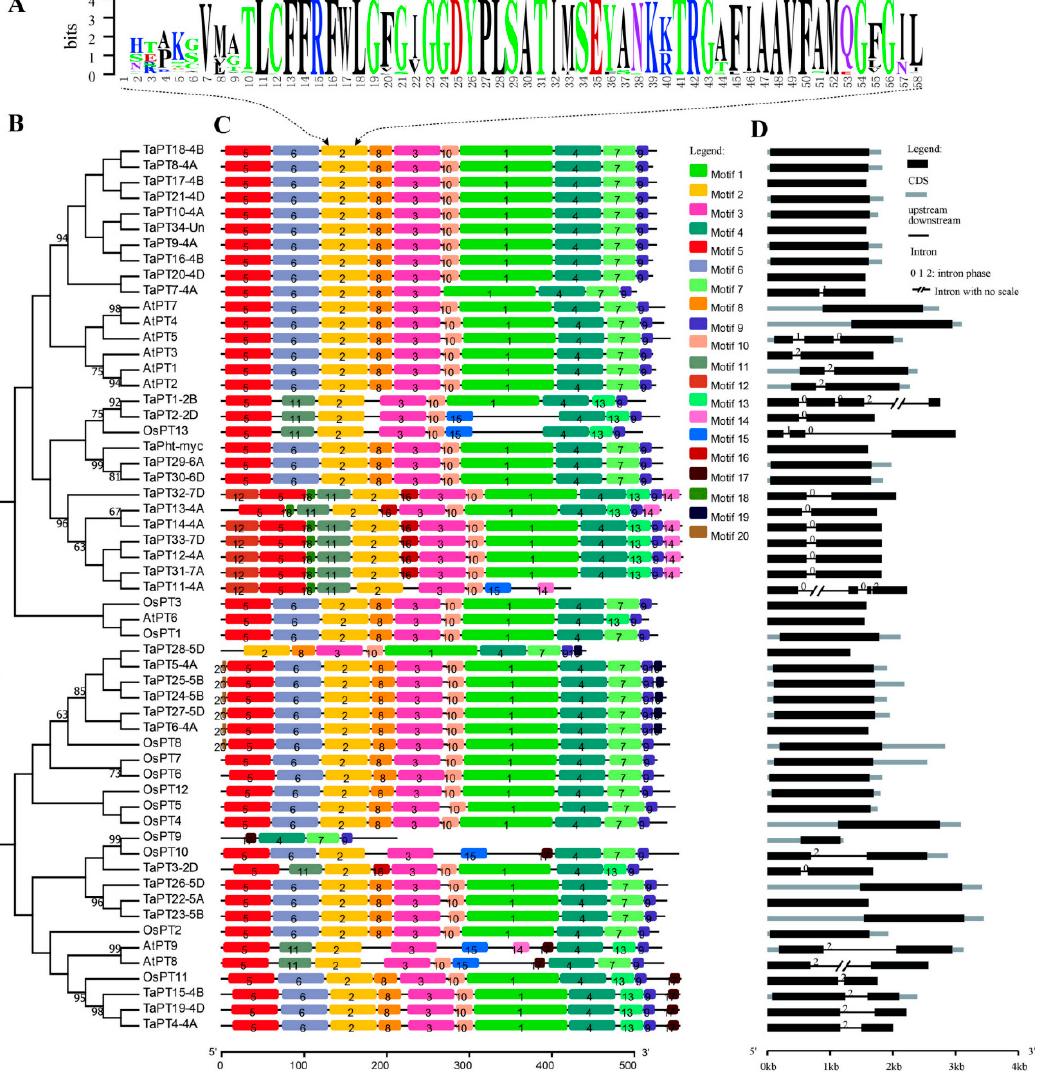
Figure 2. Sequence features and phylogenetic relationships of PHT1 genes in wheat, rice and Arabidopsis . ( A ) The sequence logo of the conserved motif 2 was generated by Weblogo. ( B ) The phylogenetic tree was built as described in Section 2, and bootstrap values are mapped on the branches. ( C ) All the PHT1 proteins were analyzed using MEME for conserved motifs; 20 conserved motifs were named motifs 1–20. ( D ) Structures of the PHT1 genes visualized using GSDS.